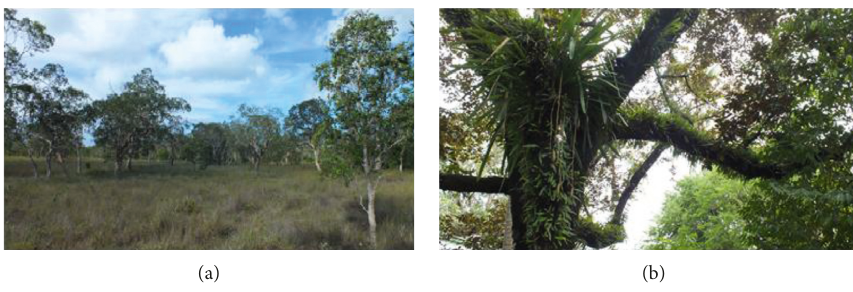
Figure 2: Dry savanna environment (a) and phorophyte with epiphyte soil in dry savanna